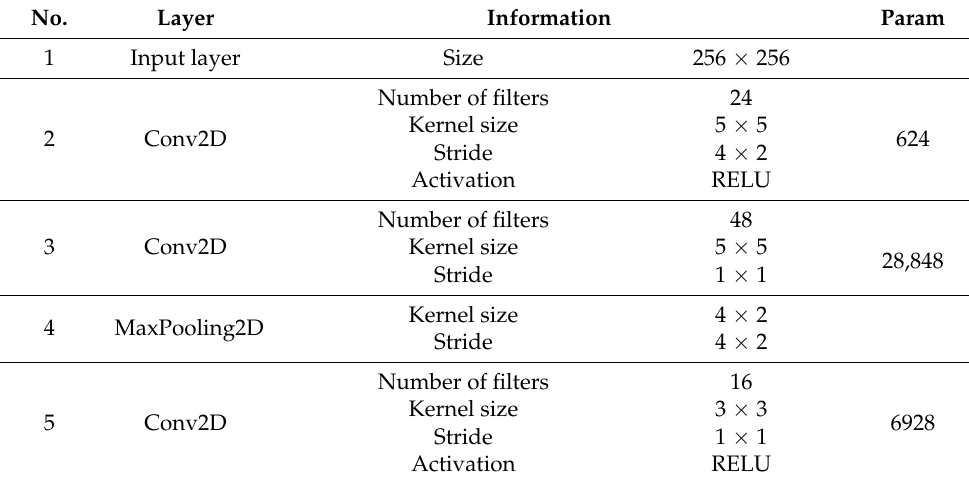
Figure 3. Architecture of the hybrid model. Table 2. Structure and parameters of proposed CNN